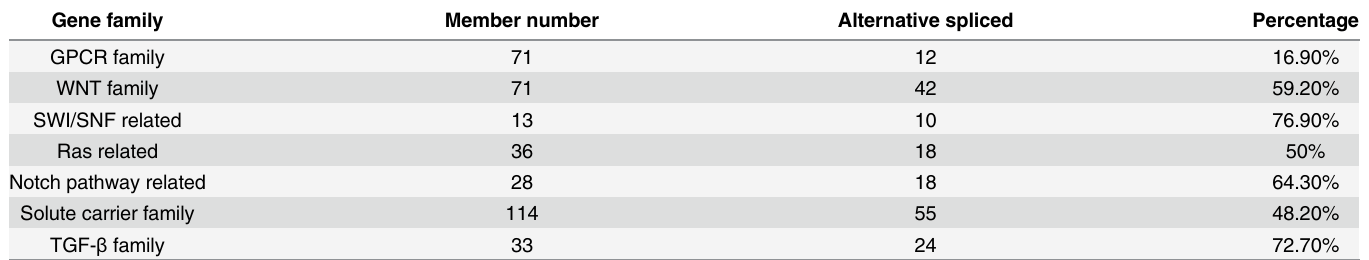
Table 2. Statistics of alternative splicing in different gene families.